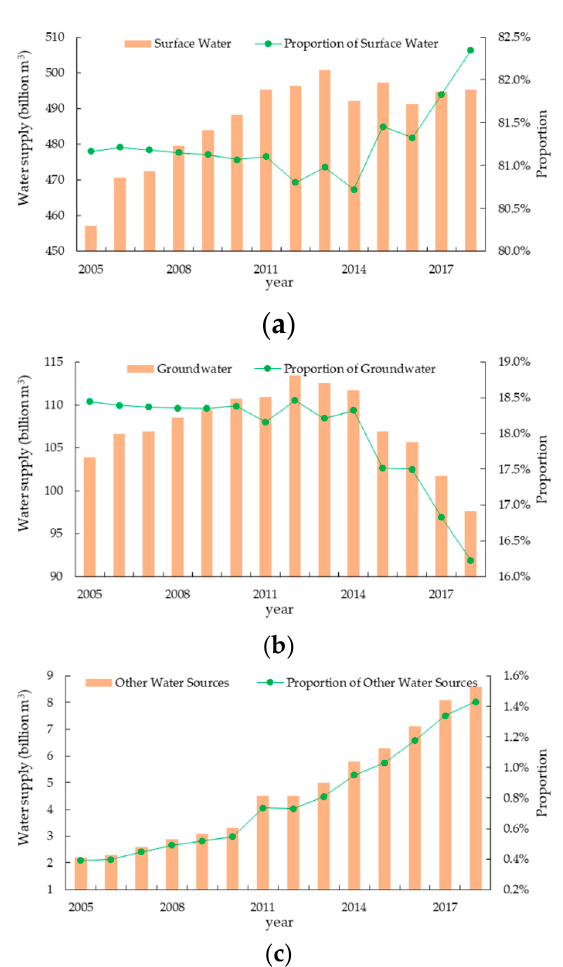
Figure 2. Annual water supply by various water sources and its share in total water supply as follows: ( a ) surface water; ( b ) groundwater; ( c ) other water sources.